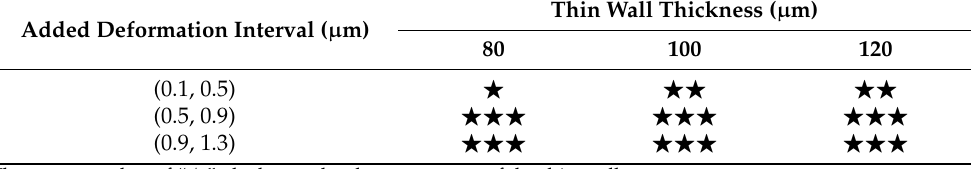
Table 9. Shape accuracy of thin wall.